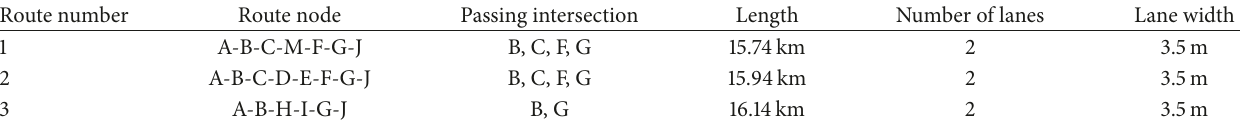
Table 1: Parameter settings.